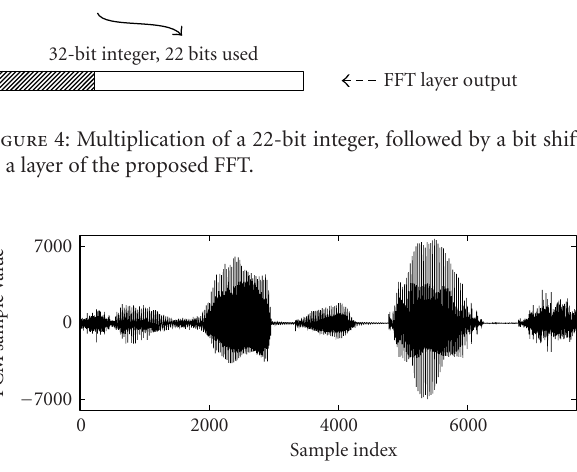
Figure 5: A speech sample from the TIMIT corpus.